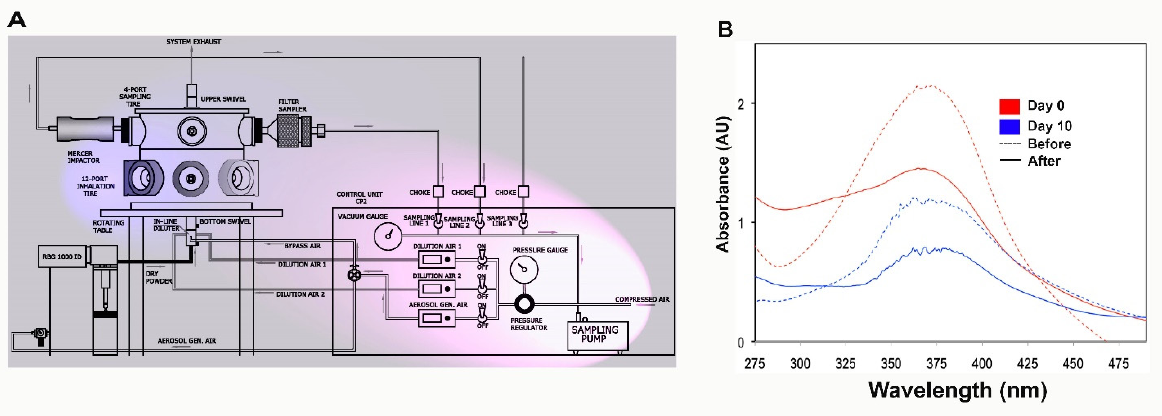
Figure 1. The design of the semi high-throughput aerosolization device for in vivo treatment of small animal models and formulation characterization. ( A ) The control module (pink shade) is comprised of a precision sampling pump, a controlled source of compressed air, which feeds directly to the aerosol generation line or other lines for dilution air when it is necessary to thin the aerosolized solution. The aerosol chamber (blue shade) is equipped with a polyvinyl fluorinated polymer cross-flow atomizer (single-pass atomizer) atomizer on the bottom of the chamber. The generated aerosol will be conveyed through an L-shaped conveyor, which projects directly to a stainless steel inhalation chamber designed to collect the aerosol and distribute it equally to gasket-tight sealed outlets capable of serving 5 animals simultaneously; ( B ) testing the stability of Thioflavin S (ThioS) formulation in dd water at the concentration of 2% ( w / v ). The solution was split into two batches; one was immediately tested. The other was kept in the dark at room temperature and tested with an identical procedure 10 days later. The absorbance of ThioS at lambda max 374 nm in water was assessed using a spectrophotometer before and after passing the solution through the atomizer on day 0 (red curves) and day 10 (blue curves). The dash lines indicate the solution before being aerosolized, while continuous lines represent the solution after being aerosolized.